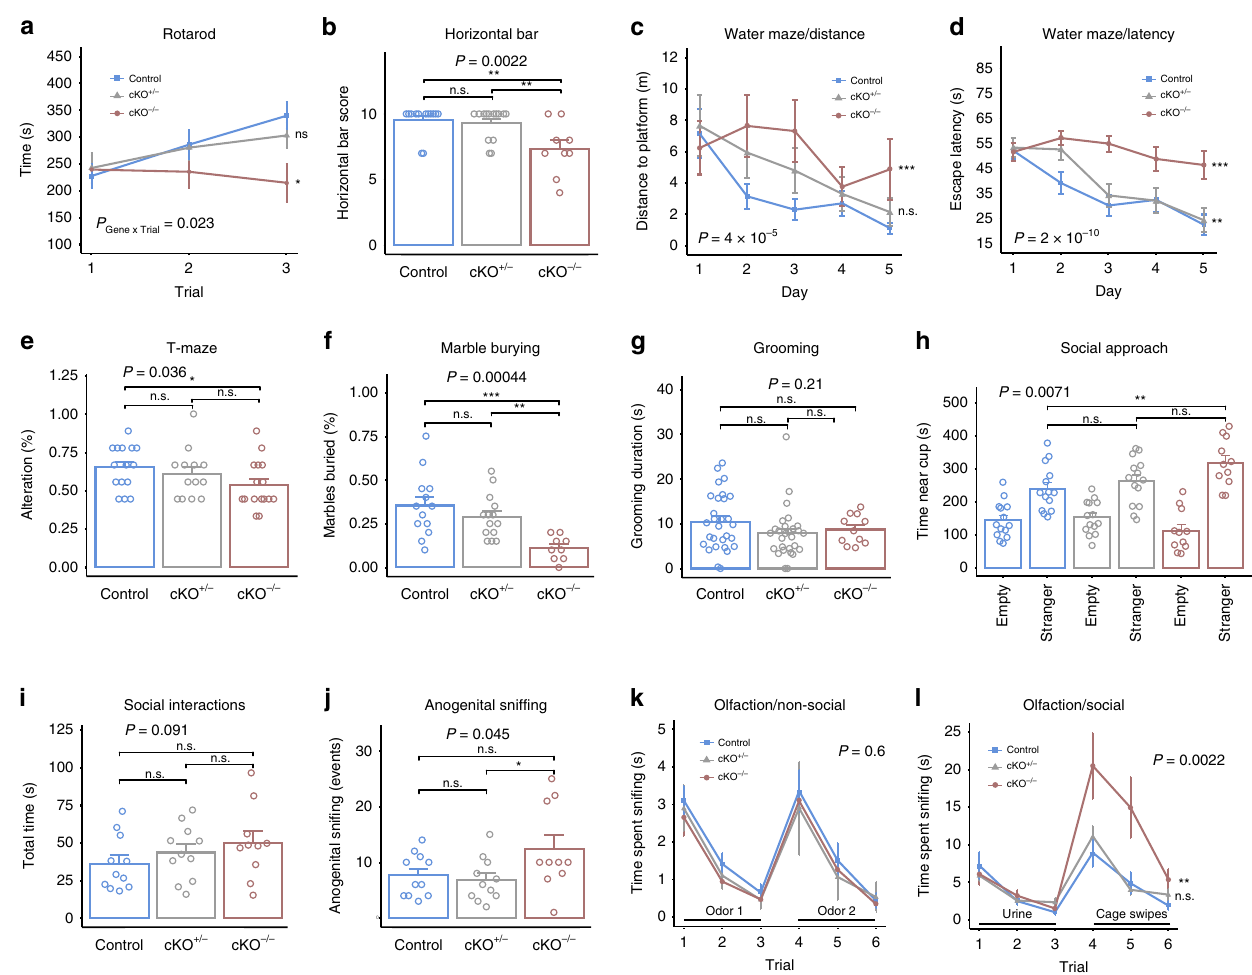
Fig. 3 Pogz -de fi cient mice show abnormal motor, cognitive and social behavior. a Time spent on the accelerated rotarod for three consecutive trials. Repeated measures ANOVA; n = 26 control (blue), 25 cKO + / − (gray), 11 cKO − / − (red). b Time taken to cross or fall from the horizontal bar calculated as a score. n = 13 control, 14 cKO + / − , 9 cKO − / − . c , d Distance and latency to reach the platform in the Morris water maze. Repeated measures ANOVA; n = 7 control, 5 cKO + / − , 5 cKO − / − . e Percentage of correct responses in the T-maze forced alternation task across 10 trials. n = 15 control, 13 cKO + / − , 15 cKO − / − . f Percentage of marbles buried in the marble burying test. n = 13 control, 14 cKO + / − , 9 cKO − / − . g Time spent self-grooming during the open fi eld. n = 30 control, 28 cKO + / − , 11 cKO − / − . h Time spent near the cup with a stranger or the empty cup as measured in the three-chamber sociability test. n = 14 control, 14 cKO + / − , 11 cKO − / − . i Total time of social interaction events in pairs of same sex mice freely behaving in the cage. n = 11 control, 11 cKO + / − , 10 cKO − / − . j Number of nose-to-anogenital snif fi ng events in pairs of same sex mice freely behaving in the cage. n = 11 control, 11 cKO + / − , 10 cKO − / − . k The time spent snif fi ng nonsocial odors in the olfactory habituation – dishabituation test. Repeated measures ANOVA; n = 11 control, 12 cKO + / − , 12 cKO − / − . l Time spent snif fi ng urine and cage odors in the olfactory habituation – dishabituation test. Repeated measures ANOVA; n = 20 control, 23 cKO + / − , 9 cKO − / − . The P values at the top of the plots ( b − i ) are for association between the quantitative measurements and the number of intact Pogz alleles calculated with a linear regression model (unless stated otherwise). Pairwise comparisons between genotypes was calculated by two- tailed t test and the signi fi cance is represented by: * P < 0.05; ** P < 0.01; *** P < 0.001; n.s. not signi fi cant. For repeated measures, the symbols represent the signi fi cance of the difference from the control. Quantitative data are mean ±